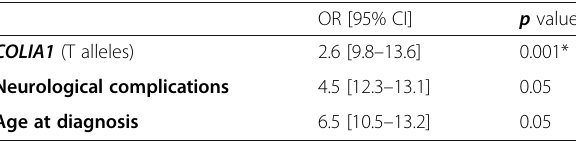
Table 7 Logistic regression analysis of different risk factors affecting bone mineral density of lumbar spine (BMD LS ) in acute lymphoblastic leukemia patients after 3 years (the second